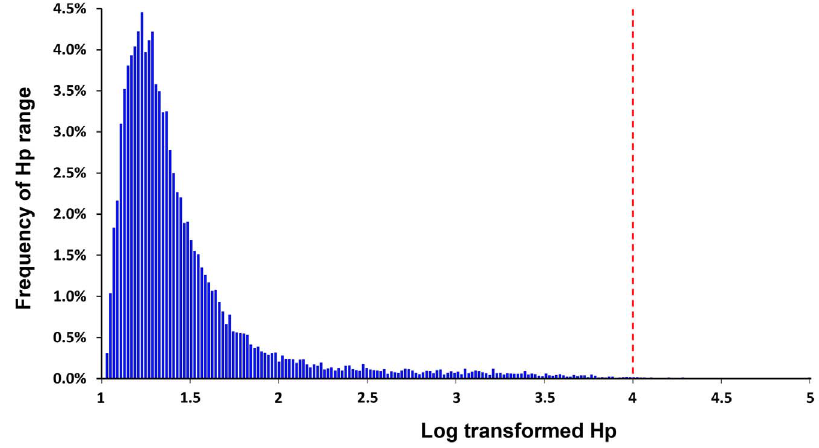
Figure 4. Histogram of log-transformed pooled heterozygosity ( Hp ) values. The x-axis is evenly divided into 200 bars from 1 to 5, and each bar represents a transformed Hp range of 0.02. The y-axis represents the percentage of each transformed Hp range in the total 200 transformed Hp ranges. All Hp values were transformed by –log 2 .